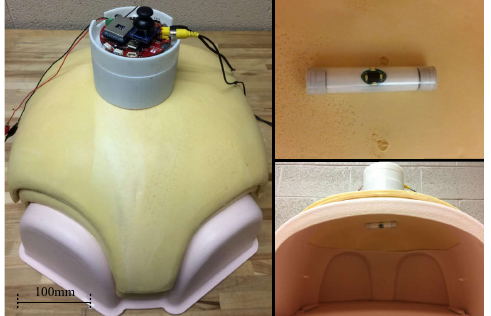
Figure 11. Ex vivo phantom experiment setup in a 3-Dmed ® synthetic abdomen